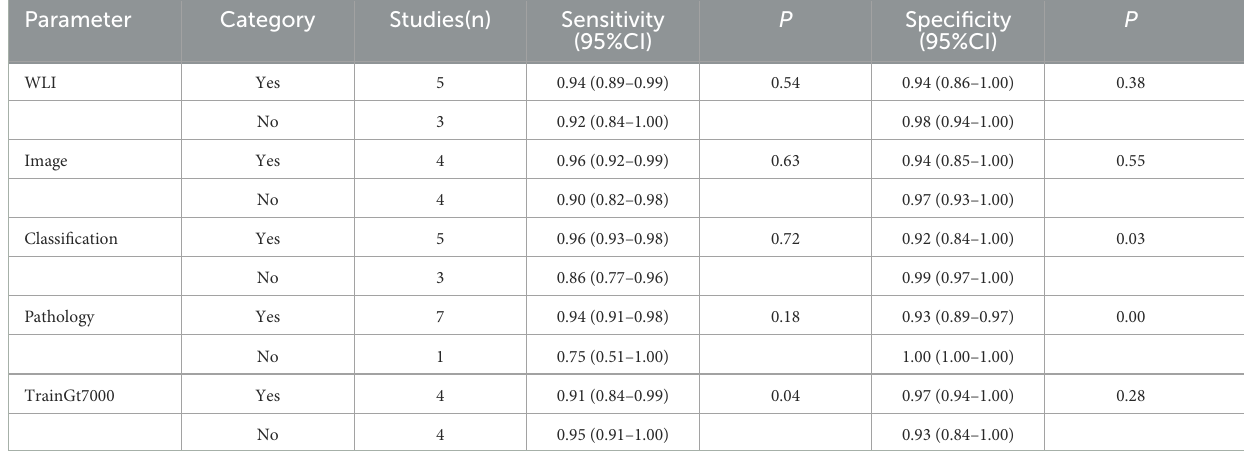
TABLE 2 Subgroup analyses and meta-regression results.